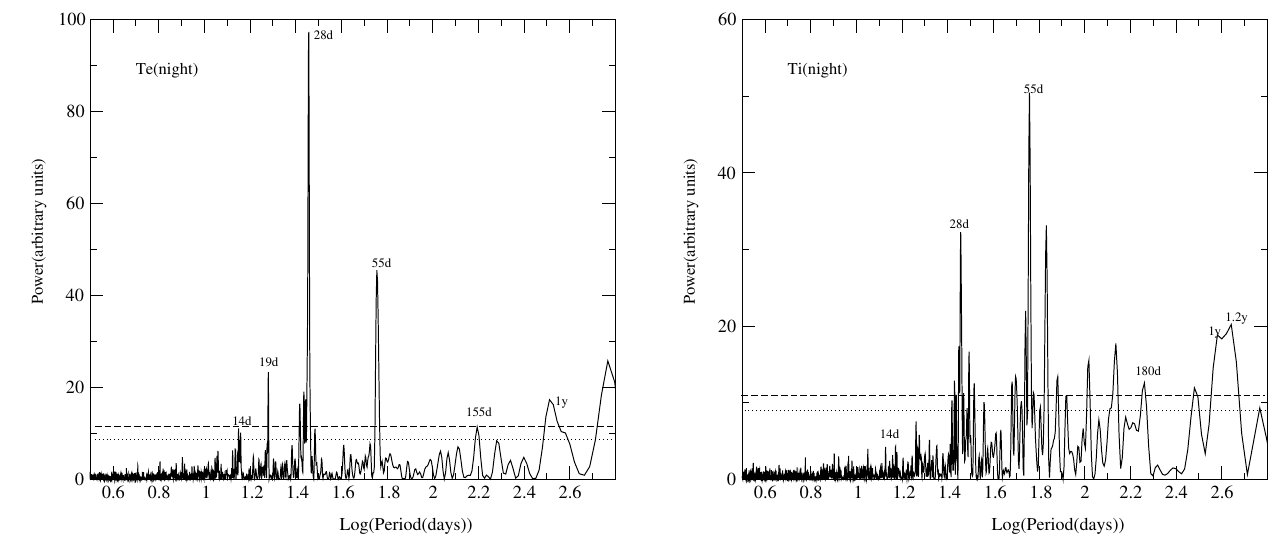
Fig. 6. Spectrum of nighttime ion temperature. The numbers in the figure indicate the corresponding period in days. Confidence levels same as in Fig.